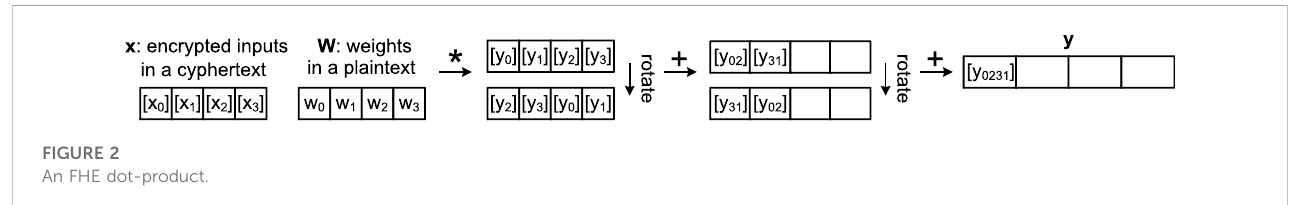
FIGURE 2 An FHE dot-product.